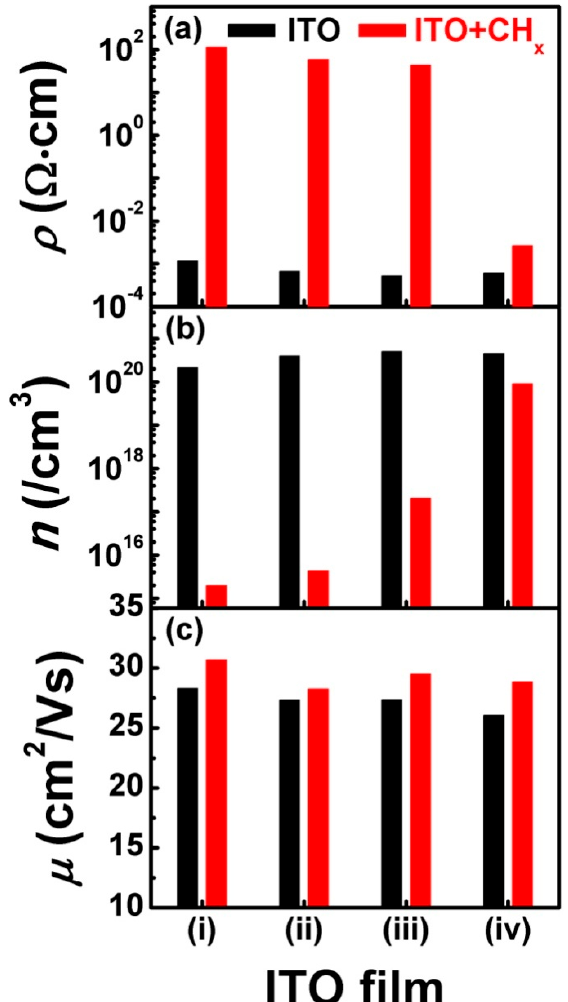
Figure 4. The electronic property of ITO films before and after CH + x beam bombardment. ( a ) for resistivity; ( b ) for carrier concentration and ( c ) for carrier mobility.